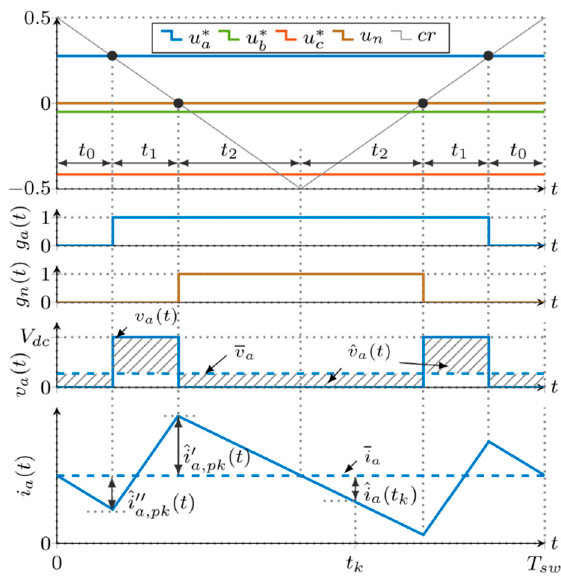
Figure 2. Modulating signals of corresponding legs in four-leg VSC (top), AC terminal voltage (middle), and phase A current (bottom) in one switching period in the case of a generic pulse-width modulation (PWM) pattern.